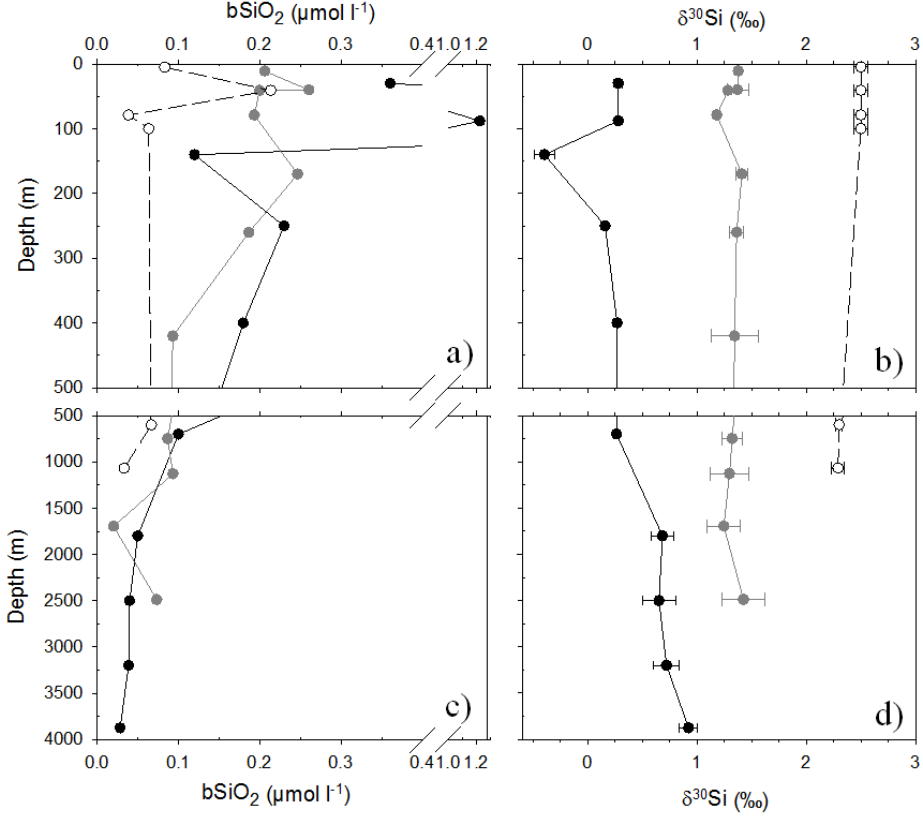
Fig. 4. Vertical profiles for the stations in the Weddell Gyre (filled black circles), the Antarctic Zone (filled gray circles), and the Polar Front Zone (empty black circles), respectively, super 5, super 4 and super 3. (a) and (c) bSiO 2 concentration profiles. (b) and (d) δ 30 Si profiles of bSiO 2